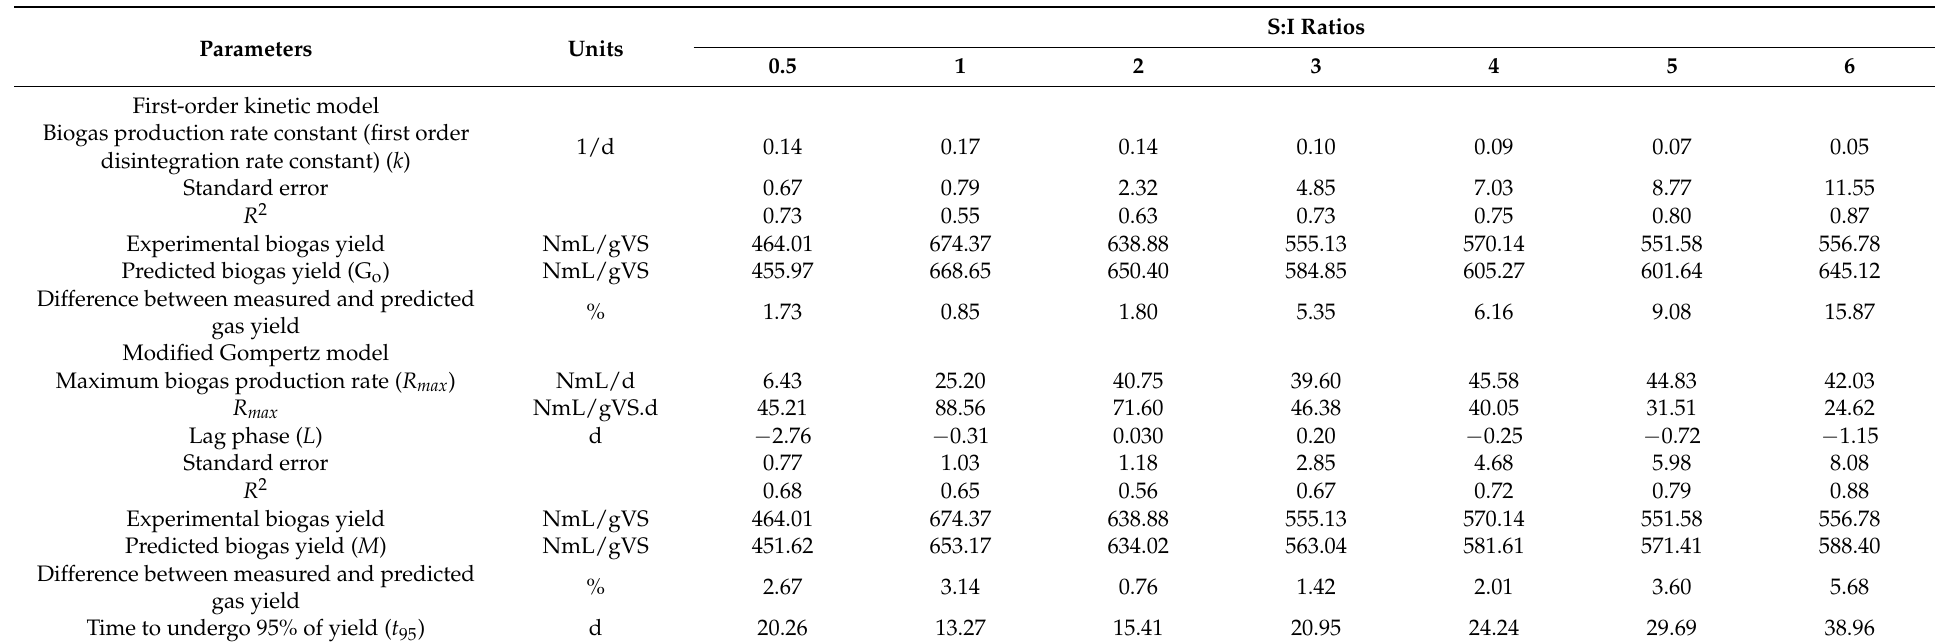
Table 3. Parameters estimated from the fitting of the first-order kinetic and the modified Gompertz model with observed data from tests with AD of FW under mesophilic conditions and different S:I